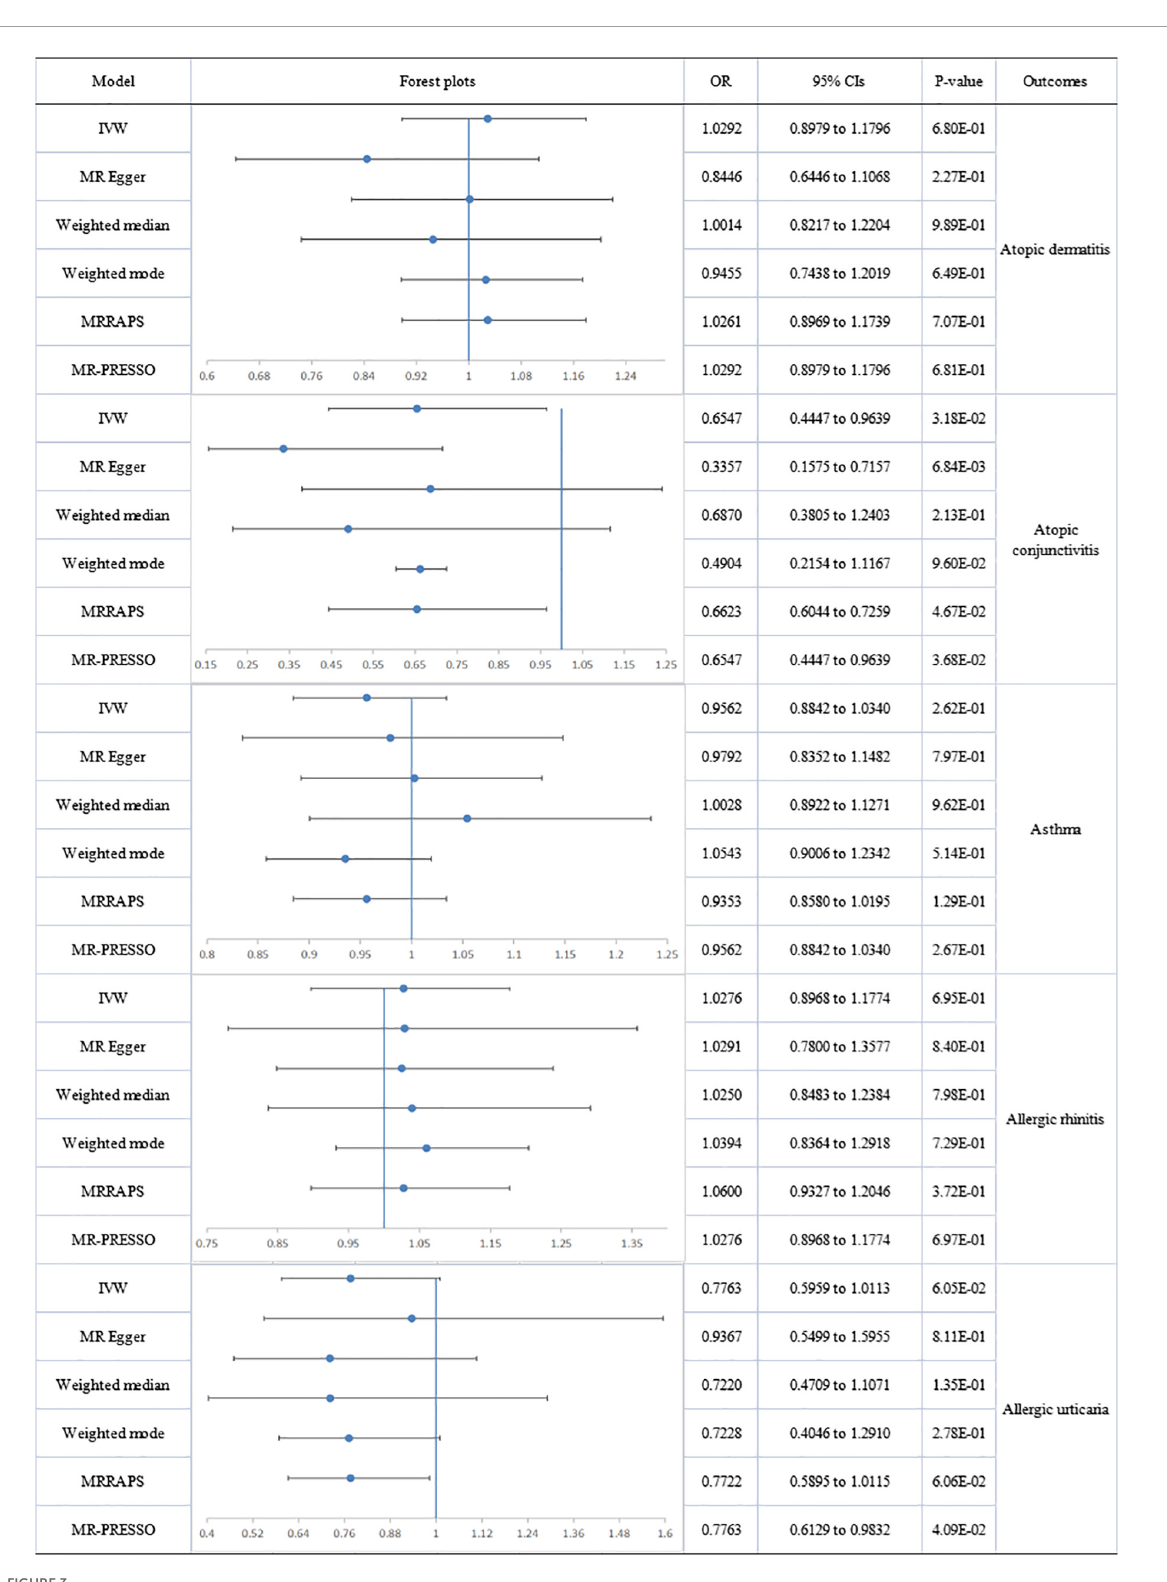
Frontiers in Nutrition